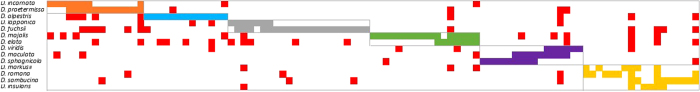
Matrix representation of the studied orchid mycorrhizal network encompassing fourteen Dactylorhiza species (rows) and putative orchid mycorrhizal operational taxonomic units (OTUs) (columns).Different colors represent different modules. Red cells are species links gluing the six modules together into a coherent network, and non-red cells are links within modules.